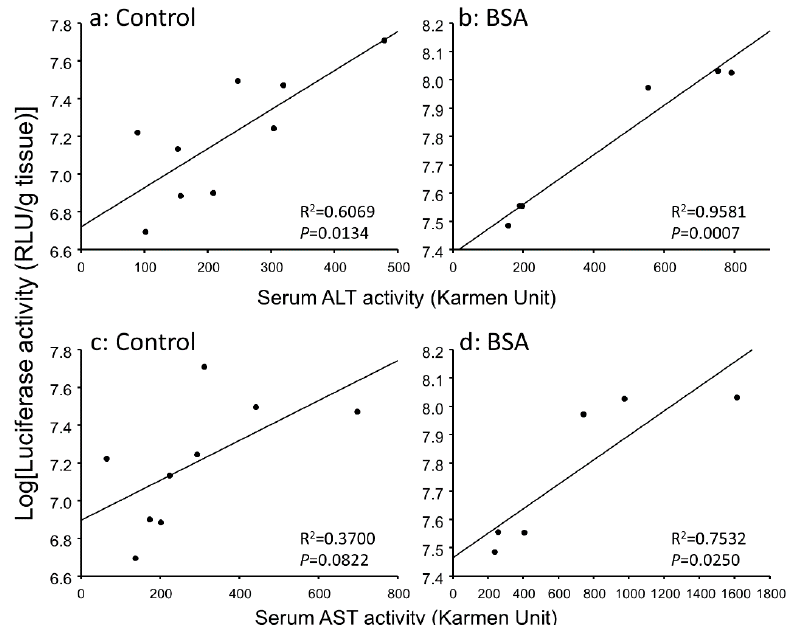
Figure 5. Relationship between pulmonary gene expression level and serum ALT ( a , b ) or AST ( c , d ) activity level 6 h after i.v. injection of lipoplex incubated with 5% glucose ( a , c ) or BSA ( b , d ) in hepatitis mice. Solid line represents the regression curve.